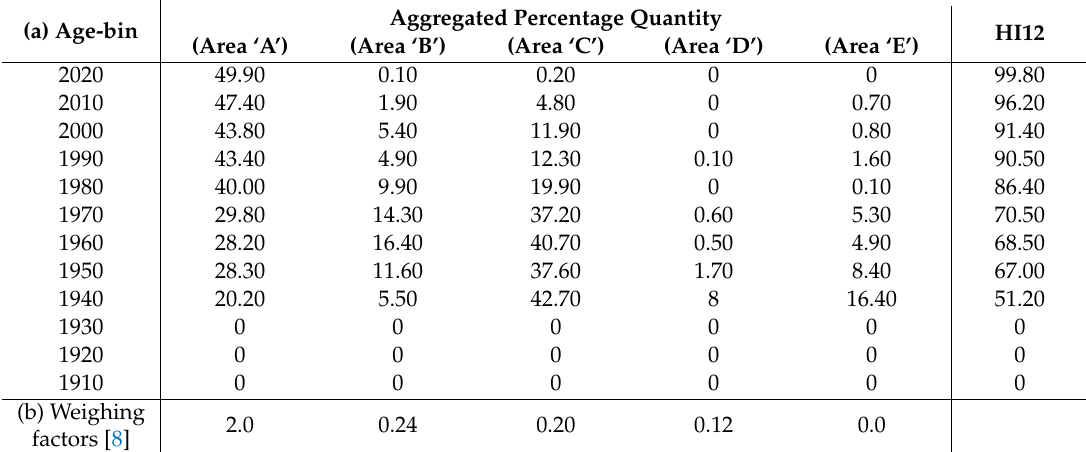
Table 3. Computation of element 12 health indexes, HI 12 (reinforced concrete